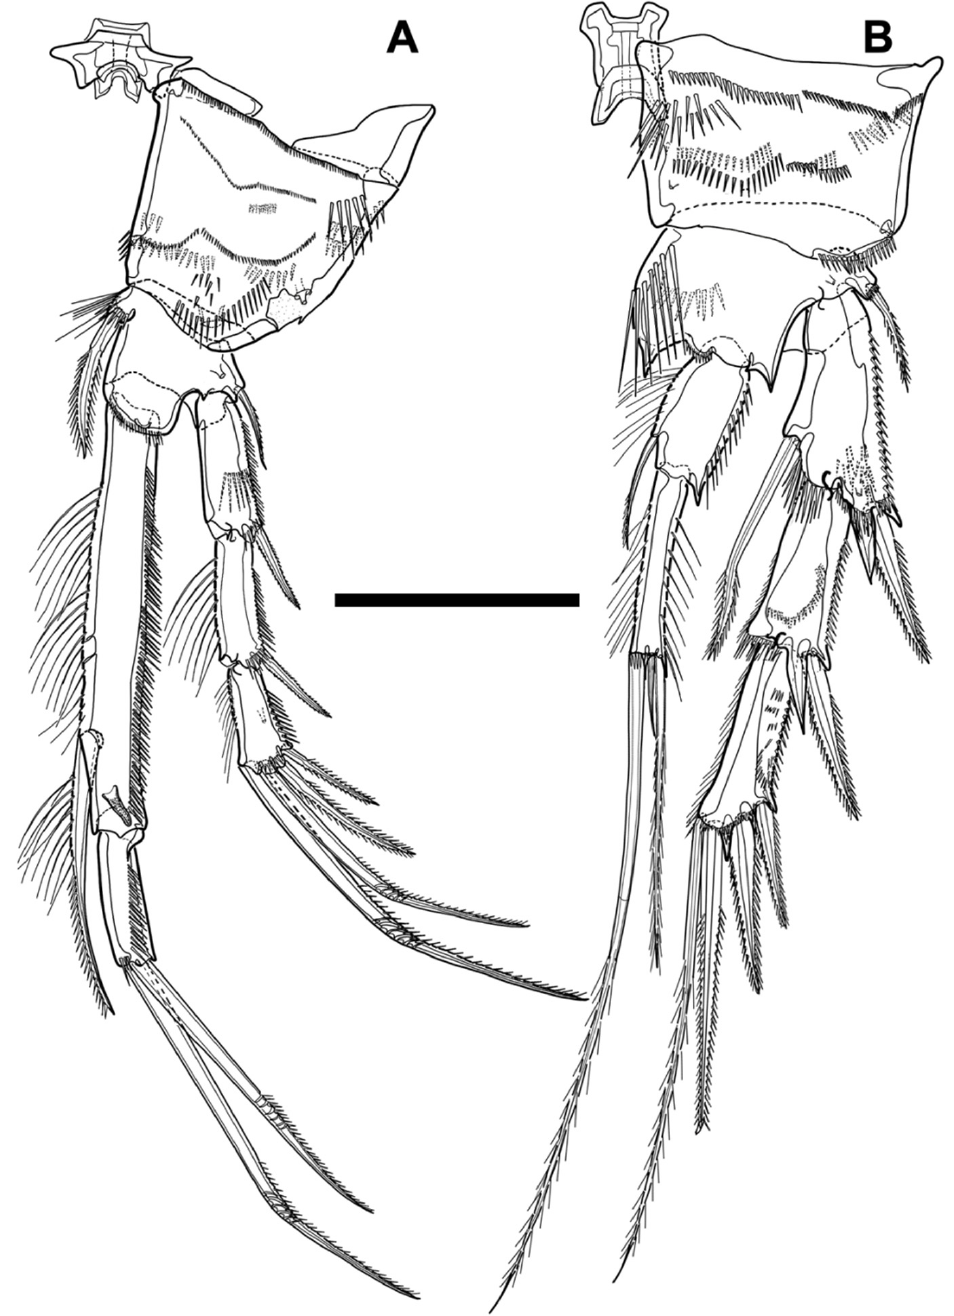
Figure 12. Line drawings of Phyllopodopsyllus saywakimi sp. nov. female (holotype): ( A ) P1; ( B ) P2. Scale bar: 50 µm.